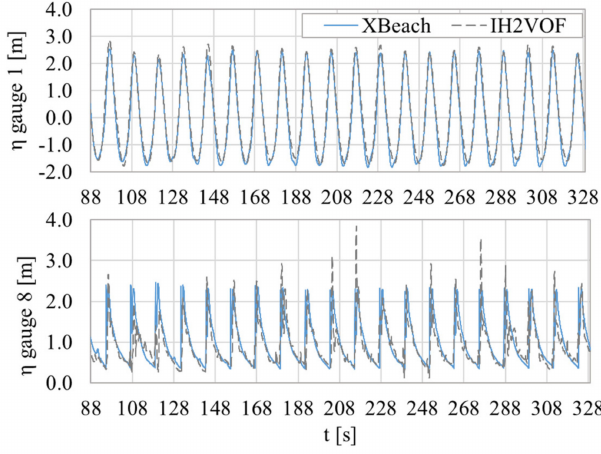
Figure 7. Free surface elevation time series at gauges 1 and 8 predicted by XBeach and IH2VOF for simplified representative hydro-morphologic conditions in case I.NO, designed for the non-occurrence of